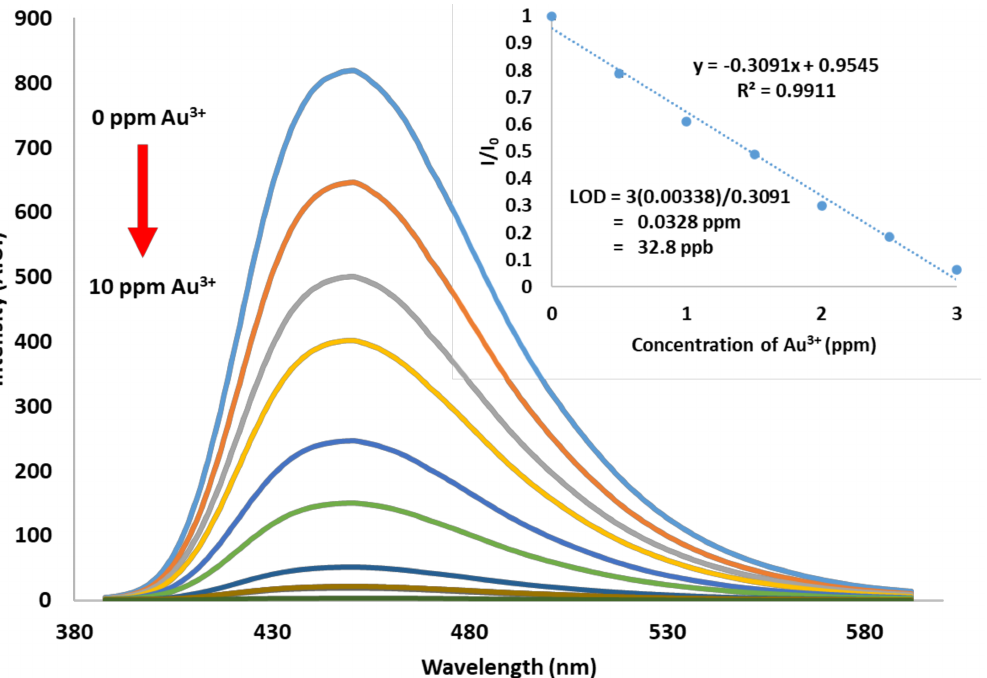
Figure 4. Fluorescence titration of DHP-OH (3.13 ppm) with various equivalents of Au 3+ (0–10 ppm) in Tris-HCl (pH 6.0) at λ ex = 369 nm and a linear graph plotted from I/I 0 and Au 3+ concentration